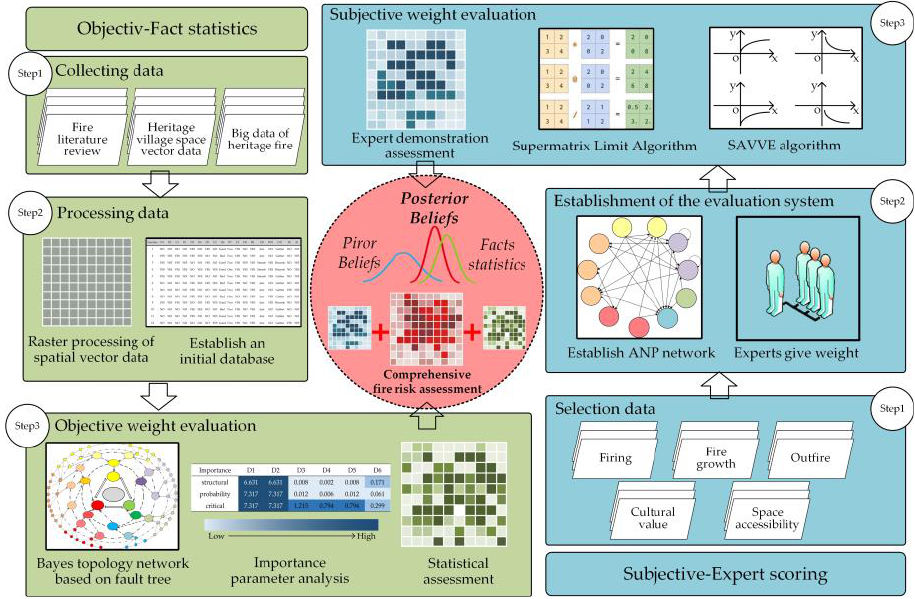
Figure 3. Fire risk assessment model flow chart.